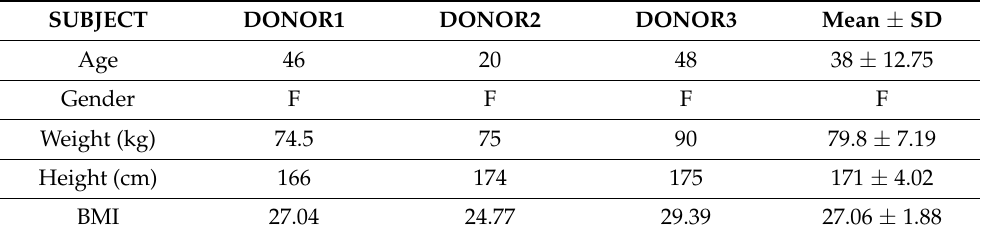
Table 1. Subject